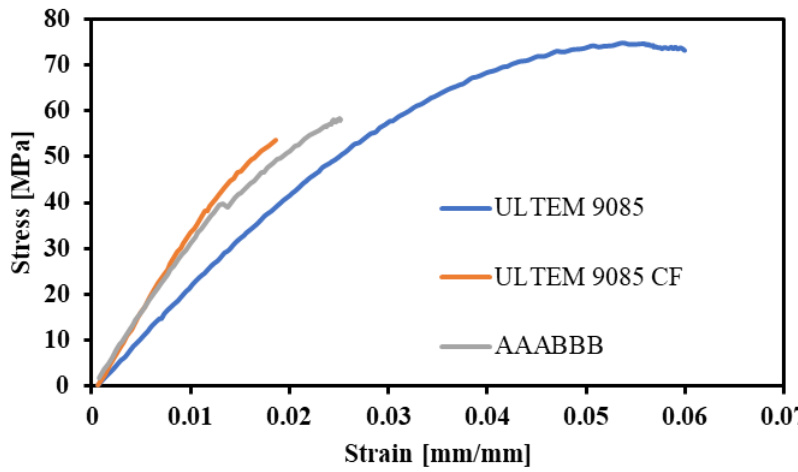
Figure 13. Stress–strain data of the single-material and multi-material (AAABBB) parts made from Figure 13. Stress – strain data of the single-material and multi-material (AAABBB) parts made from ULTEM 9085 and ULTEM 9085 ULTEM 9085 and ULTEM 9085 CF.